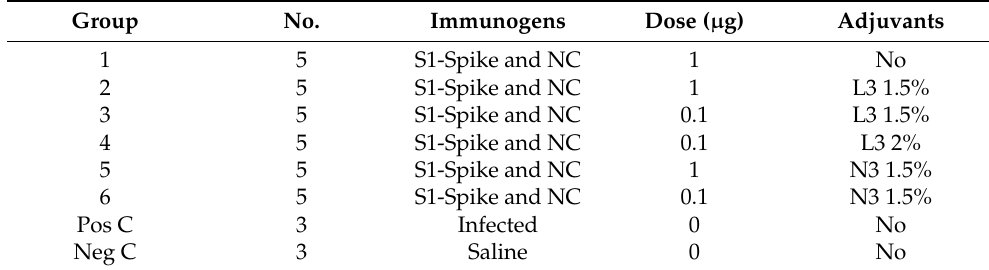
Table 1. Illustrating research groups that introduced a certain vaccine formulation at a determined dose and adjuvant concentration. Abbreviations: L3 = Cationic lipid, N3 = Anionic lipid, NC = nucle- ocapsid, Pos C = positive control, Neg C = negative control. Group No. Immunogens Dose ( µ g) Adjuvants 1 S1-Spike and